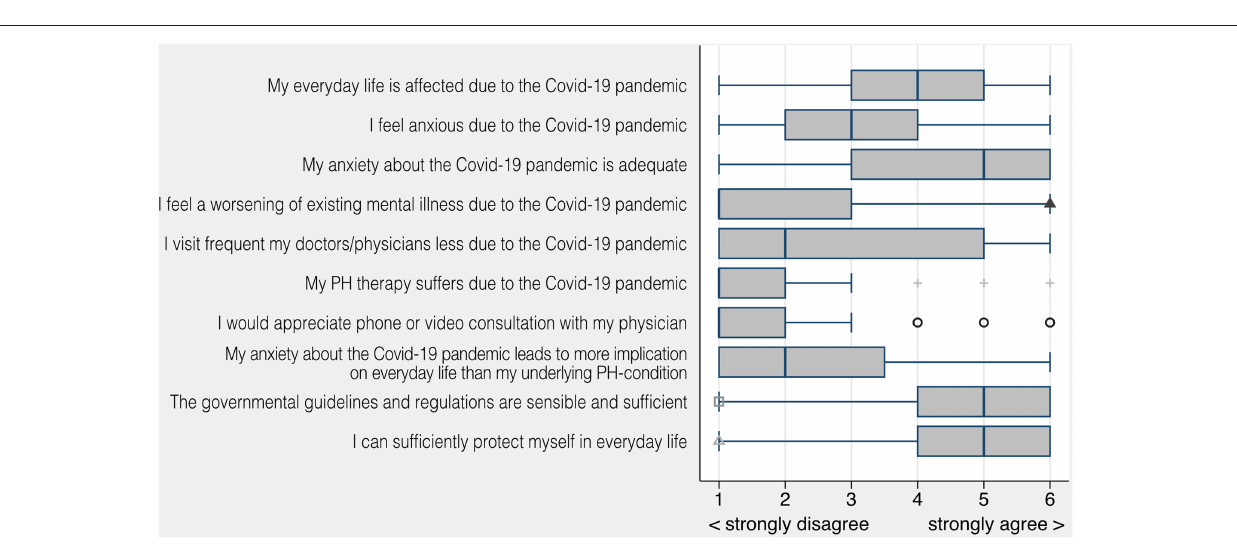
FIGURE 2 | Covid-19 pandemic specific questions; Likert scale 1 = strongly disagree to 6 = strongly